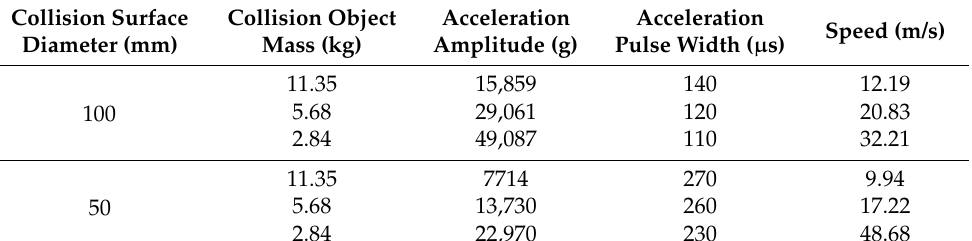
Table 2. Influences of collision objects with different masses on excitation pulse width.